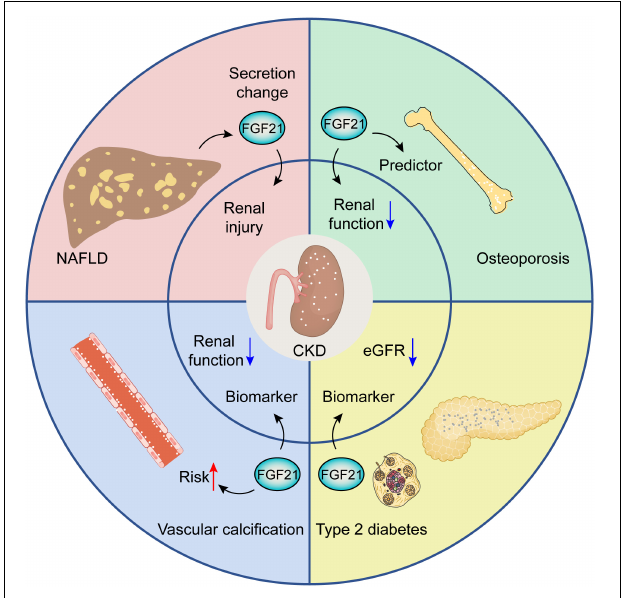
FIGURE 2 | The potential roles of FGF21 in CKD patients with other pathological situations, including NAFLD, osteoporosis, diabetes, and vascular